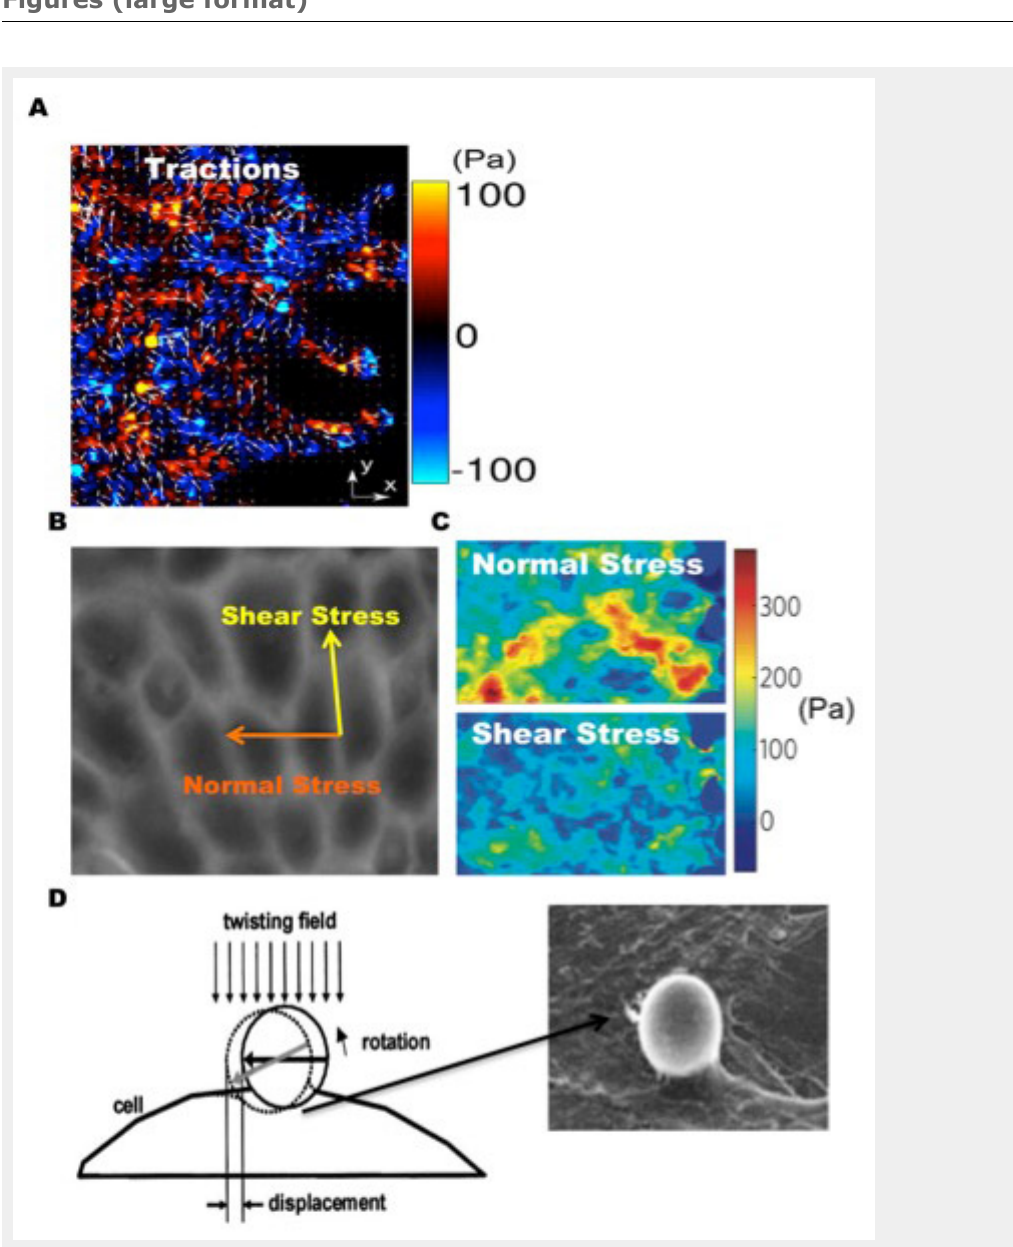
Figure 1 Cell mechanics methodologies. ( A) Colour-coded map of traction force (x-component) overlaid with arrows depicting complete traction vector (x and y component) of migrating monolayer using traction force microscopy. (B) Utilising monolayer stress microscopy we are now able to determine the normal and shear intercellular stress components within a monolayer of cells and (C) observe their corresponding spatial distributions. Cells within a monolayer are generally observed to have a rugged stress landscape and be mainly in tension. (D) OMTC is yet another useful technique used to probe cell material properties by attaching a ligand-coated magnetic bead to cell surface receptors and applying a torque to the bead with an external magnetic field. Adapted with permission from Tambe et al. Nat Mater. 2011;10(6):469–7 [14] and Fabry et al. Phys Rev E Stat Nonlin Soft Matter Phys. 2003;68(4Pt1):041914